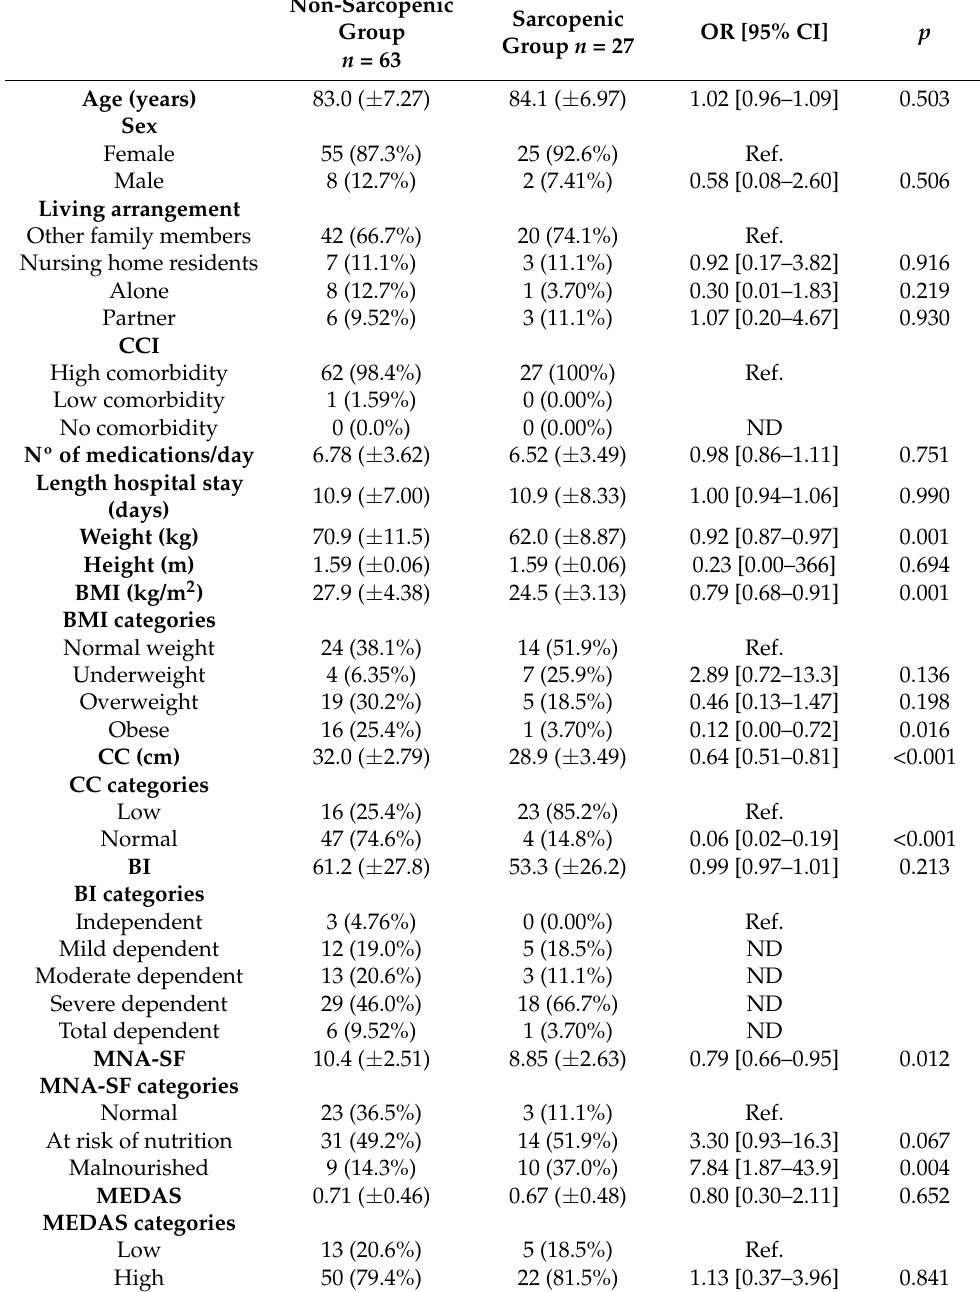
Table 2. Characteristics of older patients hospitalized for hip fractures according to the presence or absence of